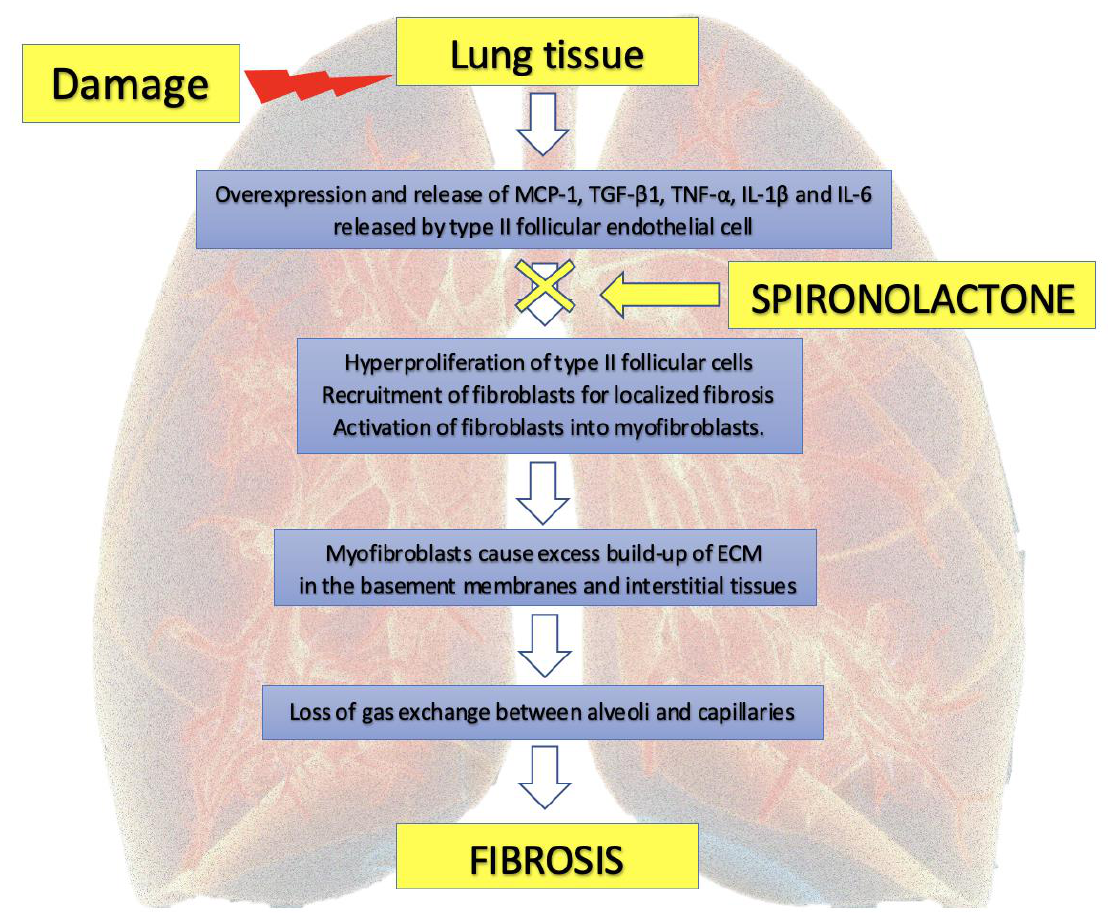
Figure 3. Potential effect of spironolactone in prevention of pulmonary fibrosis. MCP-1: monocyte chemoattractant protein-1; TGF-β1: transforming growth factor beta-1; TNF-α: tumor necrosis factor alfa, IL-1β: interleukin-1b; IL-6: interleukin-6; ECM: extracellular matrix.